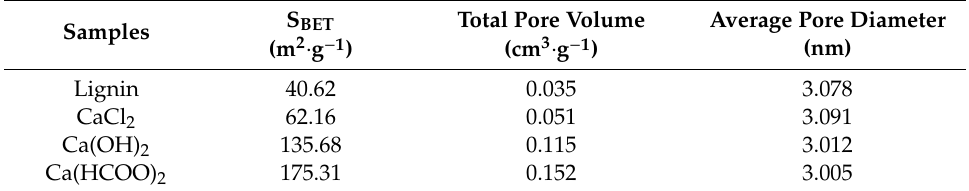
Table 2. The specific surface area and pore structure of chars from lignin pyrolysis with and without calcium salt additives.